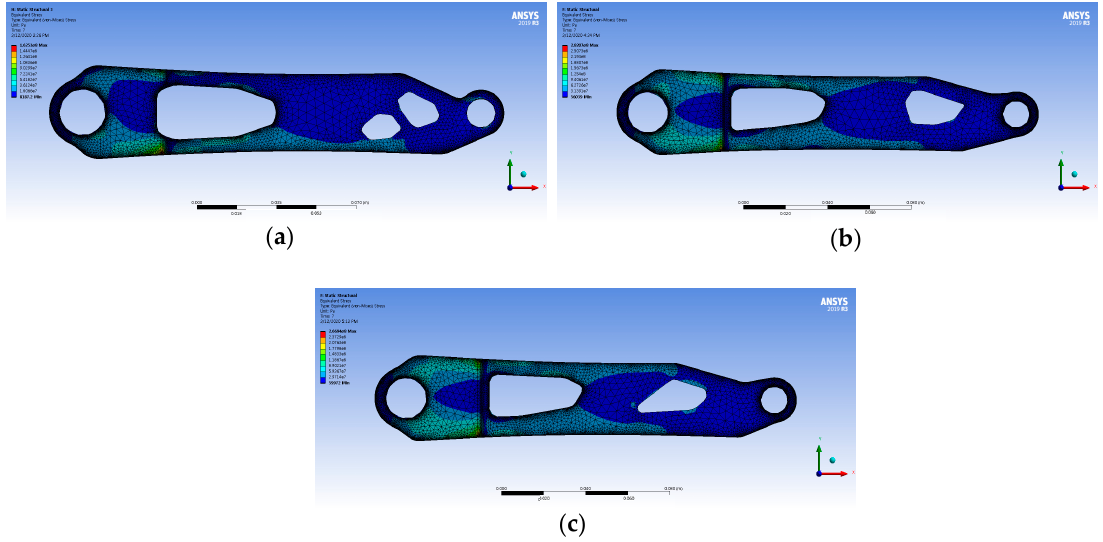
Figure 13. Effect of uphill angle (compliance minimization): (a) Case 1, (b) Case 2, (c) Case 3.